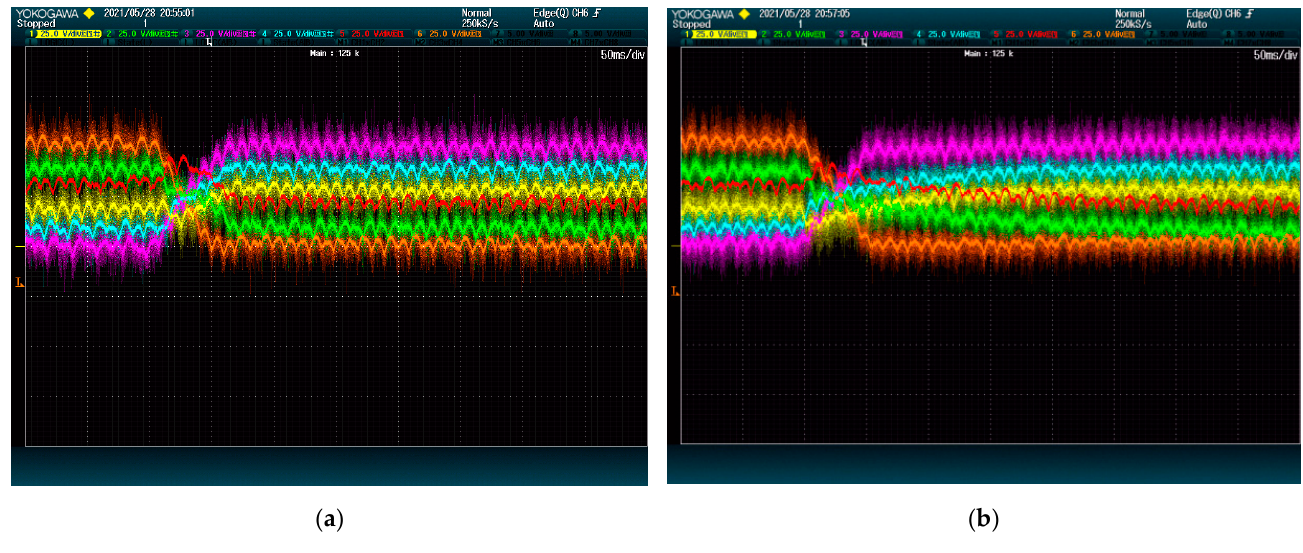
Figure 7. DC-Link voltage dynamics upon set point swap at 5 kVAr: ( a ) proposed method; ( b ) state-of-the-art alternative. The plots show voltage (25 V/div) vs. time (50 ms/div).